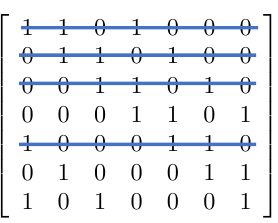
Figure 10 . We start with a cyclic Hamming code (7,4) in figure 5. We take out all codewords which have in a position 7 a 0. This leaves us with the superpotential in eq. (6.14).